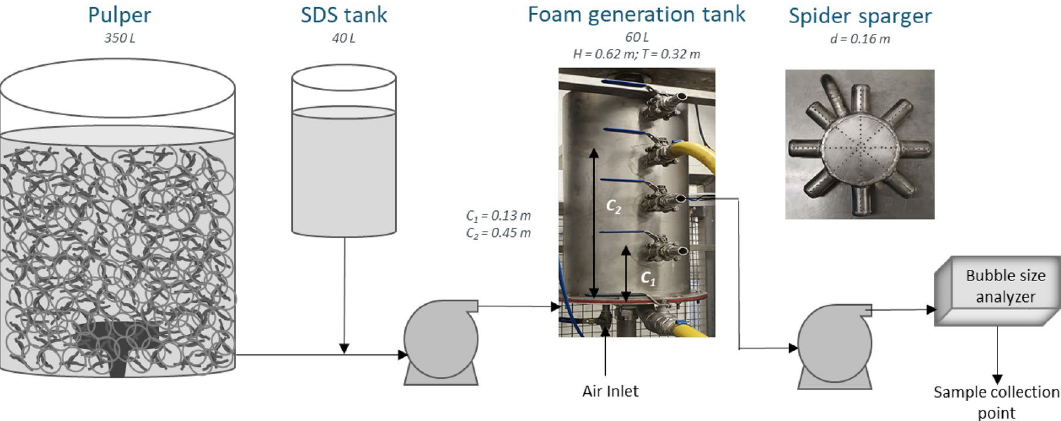
Fig. 1 Schematic representation of the experimental facility. C dynamic mixer; T = diameter of dynamic mixer; d = sparger